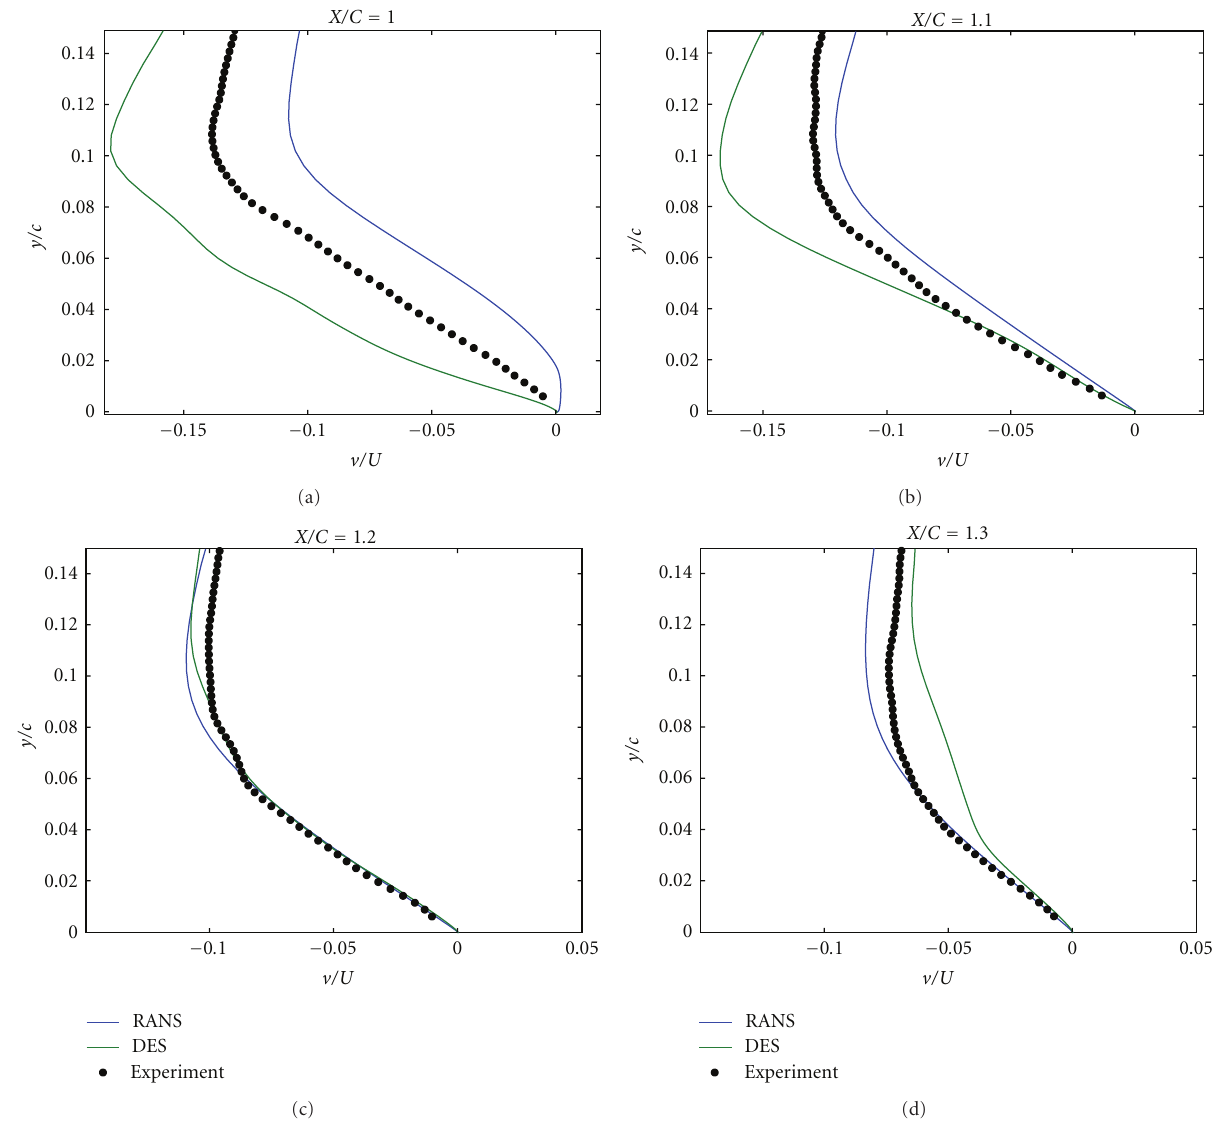
Figure 11: Mean V -velocity profile comparison at x = (a) 1 . 0, (b) 1 . 1, (c) 1 . 2, and (d)1 . 3.